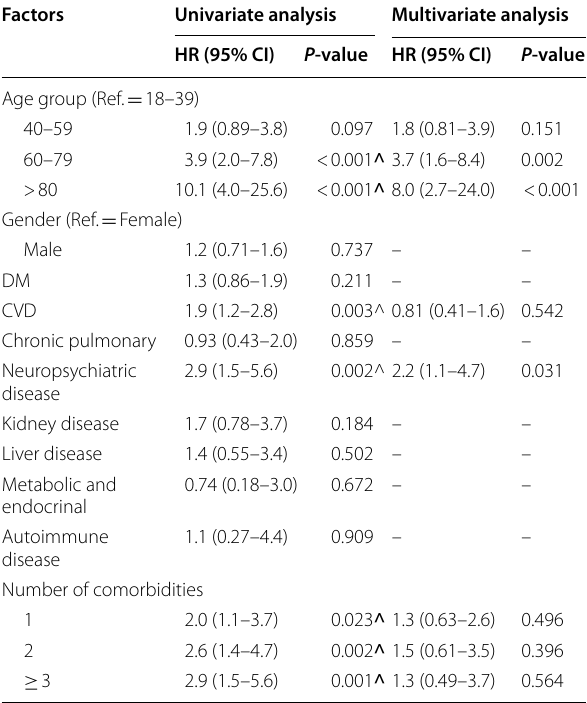
Table 6 Cox regression analysis of factors associated with overall survival in included COVID‑19 cases in the study ( n